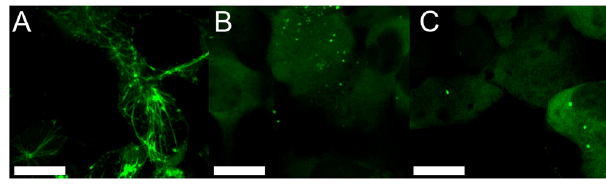
Fig. 7 Mimicking acetylation inhibits amphiphysin ’ s subcellular tubular distribution, yielding a diffuse cytoplasmic distribution. A – C Fluorescent confocal microscopy of COS-7 expressing WT-Amph-GFP ( A ) 15Q-Amph- GFP ( B ) or 5Q15Q-Amph-GFP ( C ). Scale bar = 10 µ m. Representative images taken from 3 independent